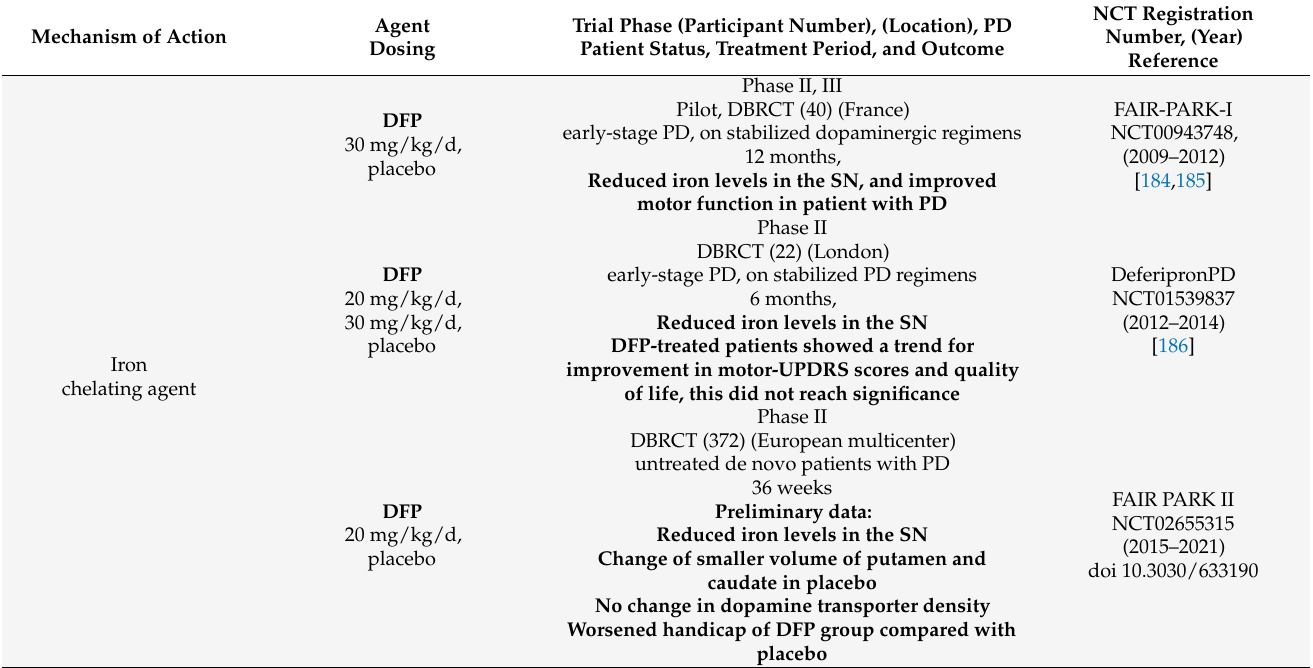
Table 2. Clinical trials of candidate agents targeting ferroptosis in